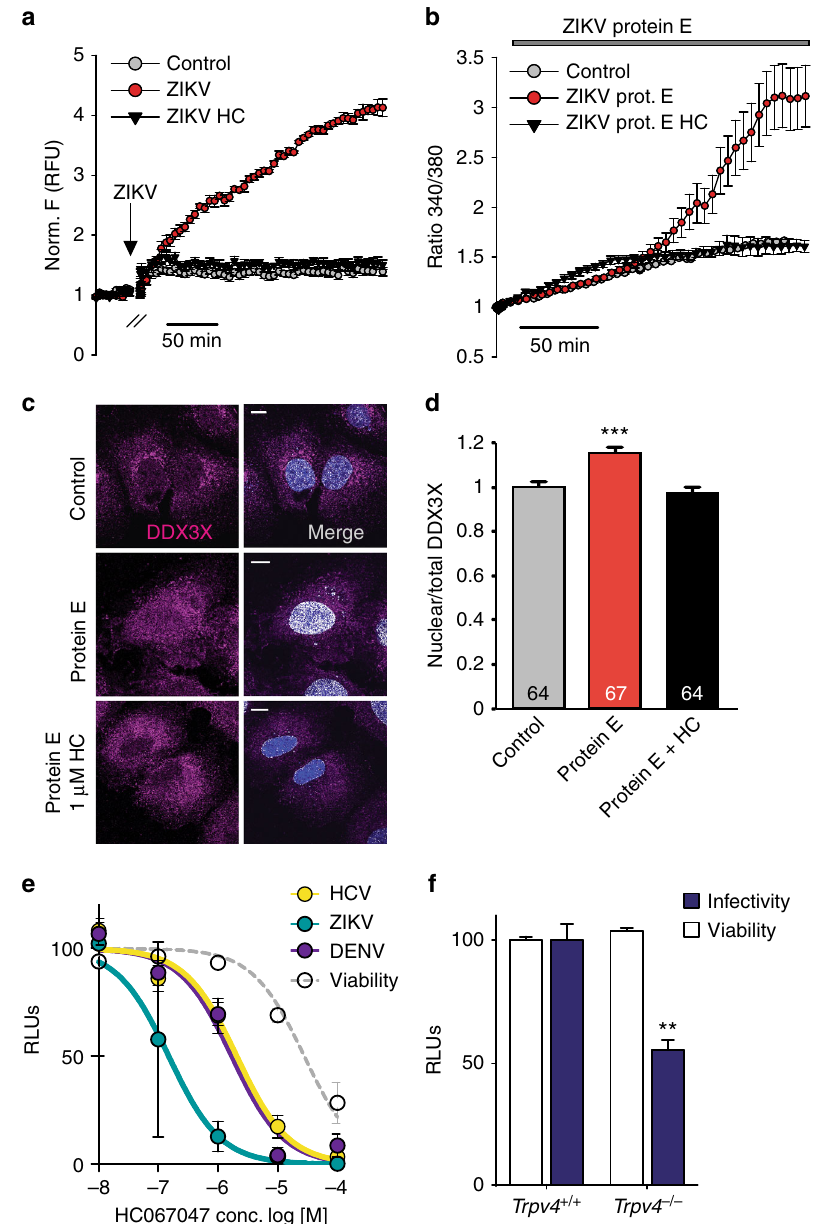
Fig. 6 TRPV4 acts as a host factor for viral replication. a Mean (±SEM) of normalized intracellular Ca 2 + obtained from 3 experiments (with 70.000 cells analyzed in each experiment). Huh7 cells were loaded with the calcium indicator Calbryte 520 AM and exposed to control, ZIKV or ZIKV + 10 μ M HC067047. b Mean ( ± SEM) of normalized intracellular Ca 2 + signals (Fura-2 ratio) obtained in Huh7 cells exposed to control ( n = 38), ZIKV (n = 48) or ZIKV + 10 μ M HC067047 ( n = 37) conditions. c Confocal immuno fl uorescence images of DDX3X in Huh7 cells exposed to ZIKV in the presence or absence of HC067047. Nuclei were stained with DAPI (blue). Colocalization of DDX3X and nuclei is shown in white in the merge panels. d Mean nuclear/ total DDX3X ratio determined under the experimental conditions indicated. e DENV, HCV and ZIKV infection in Huh7 cells treated with increasing concentrations of HC067047. The data are presented as Mean (±SEM) of three independent experiments at each HC067047 concentration. f DENV infection in Trpv4 + / + and Trpv4 − / − MEFs. Cellular viability was measured by CytoTox-Glo cytotoxicity assay and viral infectivity was measured as luciferase activity. The data are presented as Mean ( ± SEM) of three independent experiments. Data are means ± SEM. ** P < 0.01 when comparing WT with any other condition as determined by one-way ANOVA followed by a Bonferroni post hoc test ( d ) or when comparing Trpv4 + / + and Trpv4 − / − mice as determined by two-tailed Student ’ s t test ( f ). P = 0.001 for infectivity and P = 0.2 for cell viability in f . Scale bar = 10 μ